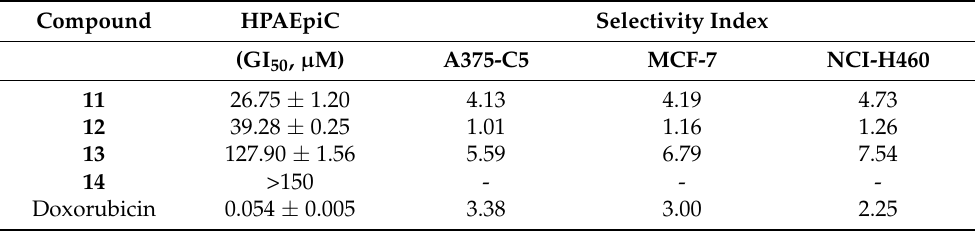
Table 3. Selectivity index of compounds 11 – 14